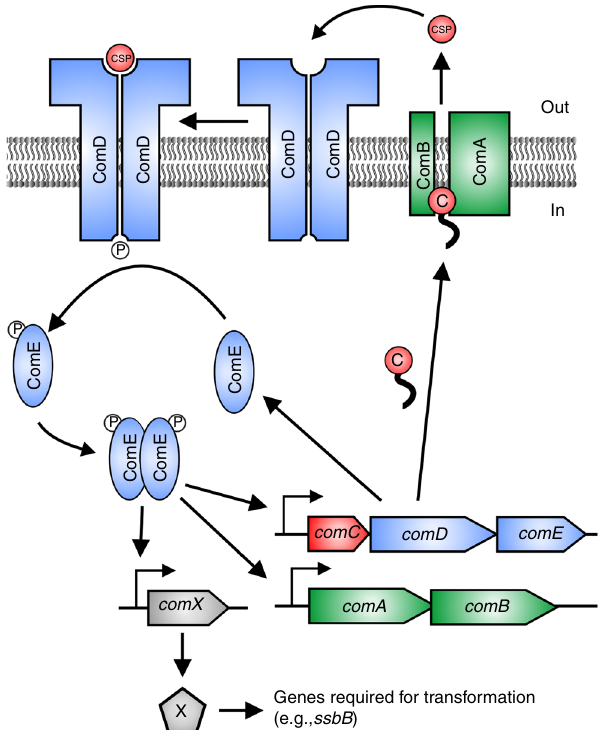
Fig. 1 Network of competence regulation in S. pneumoniae . ComC (C) binds the membrane protein complex ComAB, and it is processed and exported as CSP to the extracellular space. CSP binds to the histidine kinase ComD, which is located in the membrane as a dimer. Upon CSP binding,